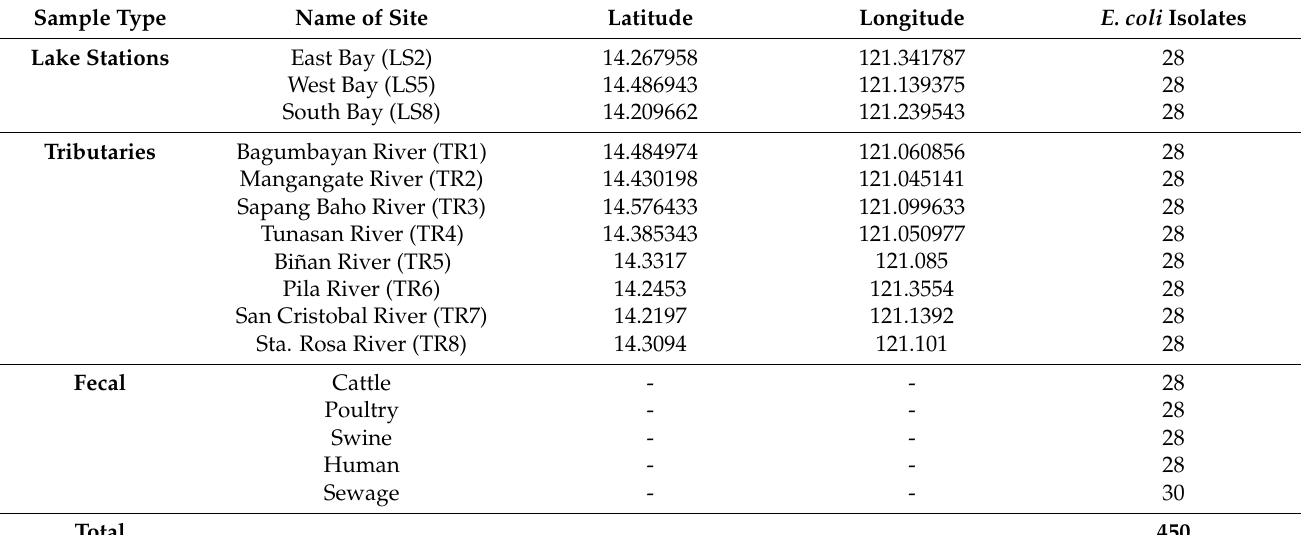
Figure 1. Sites for the collection of various sample types for the assessment of antibiotic resistance in Laguna Lake. Table 1. List of sampling sites, locations, and number of E. coli isolates used in this